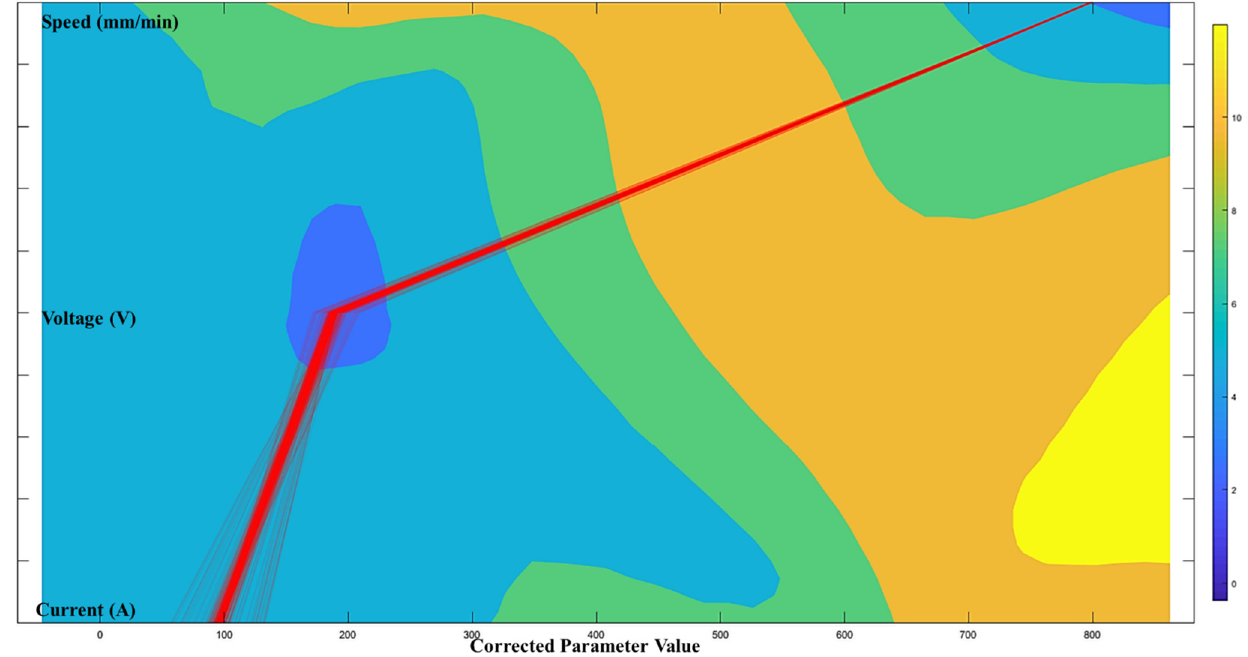
Figure 10. Optimal printable parameters for controlling BW = 3.7 mm in a 98% confidence interval.